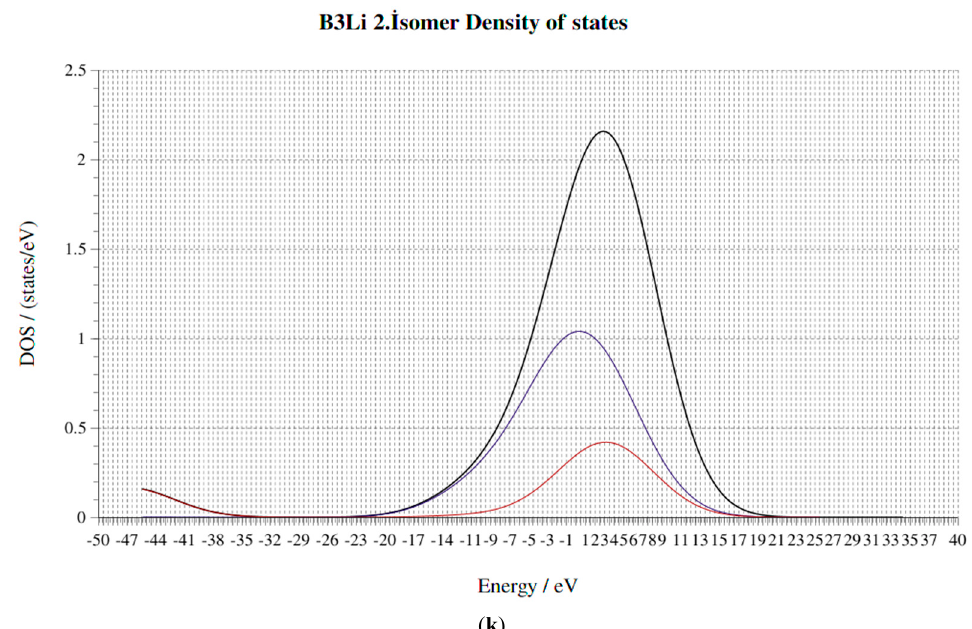
Figure 8. (a–k). The B x Li y (x = 1–3, y = 1–3) clusters of the Density of States.